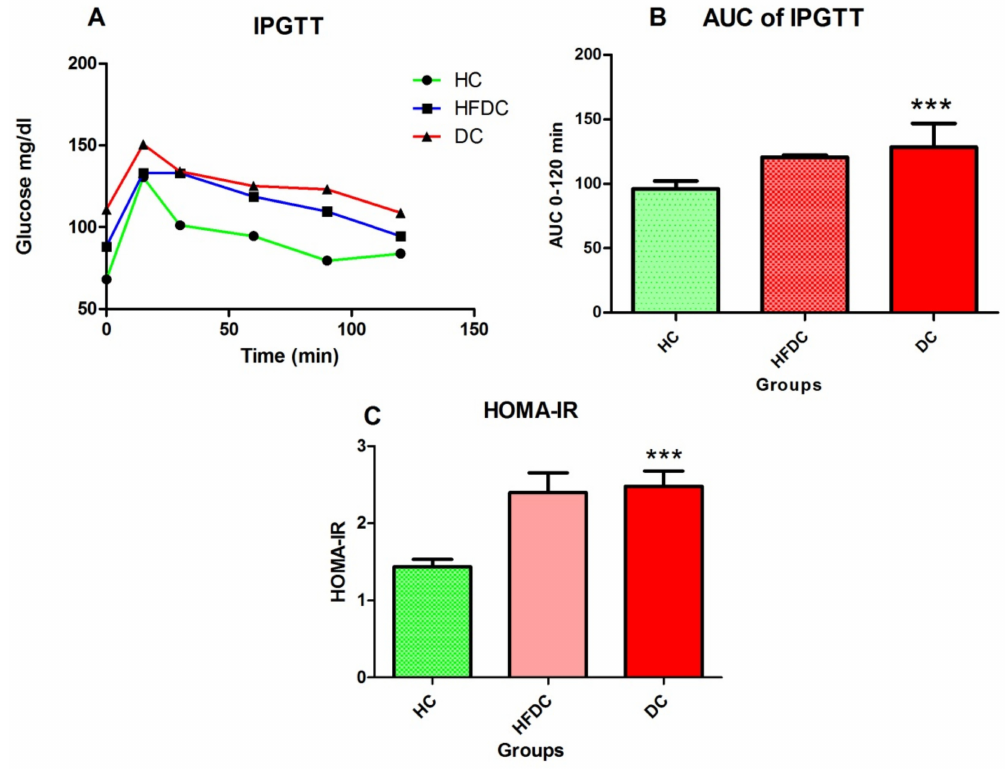
Figure 1. Intra peritoneal glucose tolerance test (IPGTT), area under curve (AUC) and HOMA-IR model for the experimental groups. ( A ) Variations in glucose levels during IPGTT. ( B ) Area under curve (AUC) for IPGTT. ( C ) Homeostasis model assessment of insulin resistance (HOMA-IR). Results are recorded as the mean of three replicates and denoted as mean ± SD ( n = 6 animals per groups). *** p ≤ 0.001, when compared with the healthy control group (Dunnett’s Multiple Comparisons Test). HC: Healthy control, HFDC: High fat diet control, DC: Diabetes